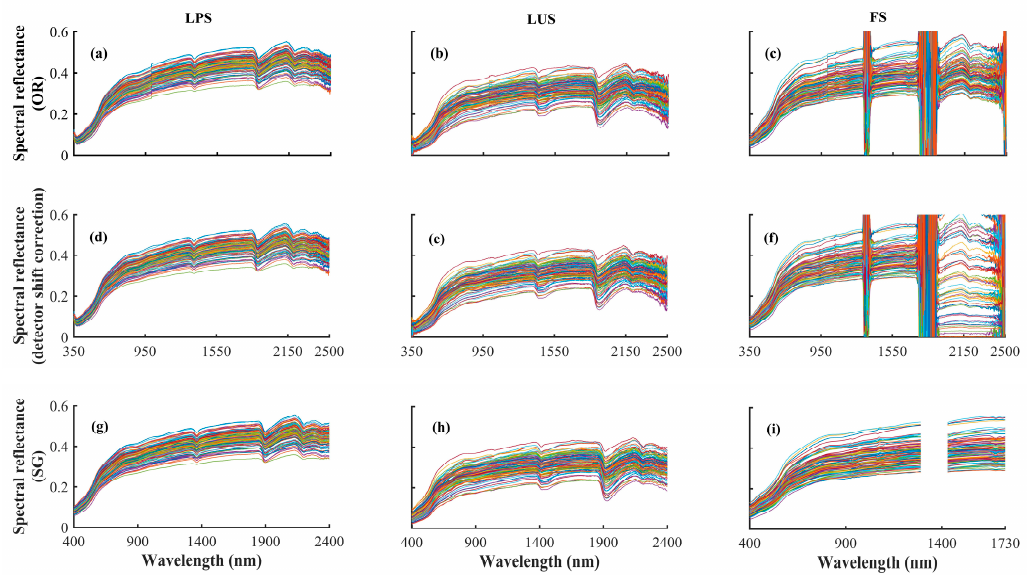
Figure 3. The plots of spectral curves of OR and SG, including laboratory-processed spectra, labor- atory unprocessed spectra, and field spectra. ( a – c ) represent the original spectra in LPS, LUS, and FS, respectively. ( d – f ) represent the corrected detector shift. ( g – i ) represent the smoothed spectra. Note: Different color lines represent spectra for each soil sample.